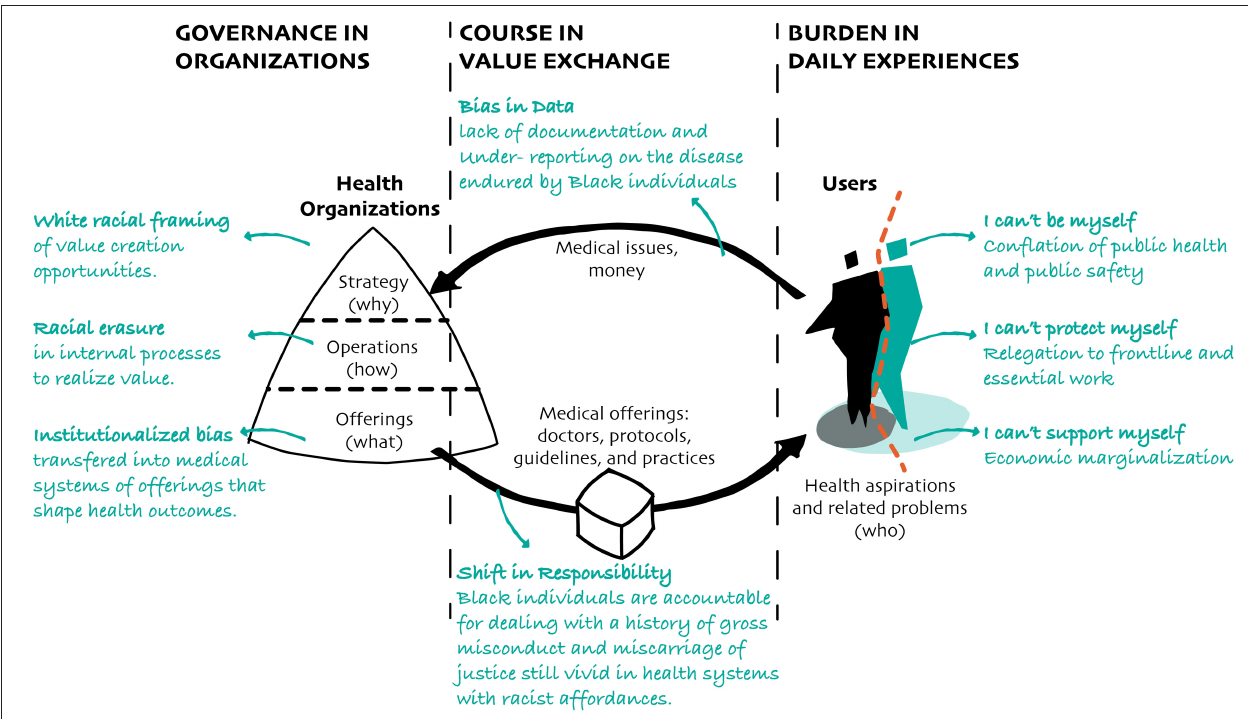
FIGURE 4 | The diagram above illustrates how critical aspirations of Black individuals, including those related to their freedom, safety, and economic security, become conditioned by health systems that carry racist affordances in disease governance and courses.